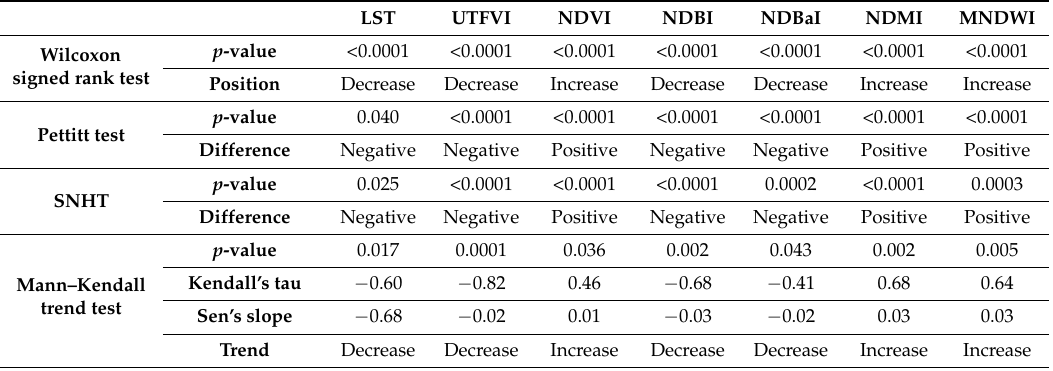
Table 5. Tests results for the Confluence site on selected dates for median LST and spectral indices. LST